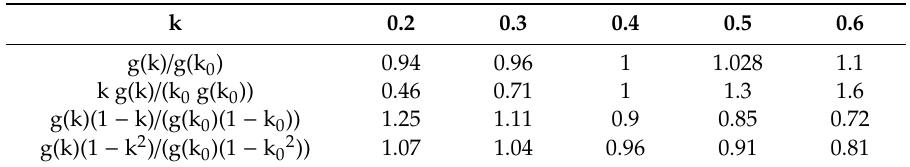
Table 1. Relative values of the main IPT electromagnetic parameters at coupling factor k in a range of